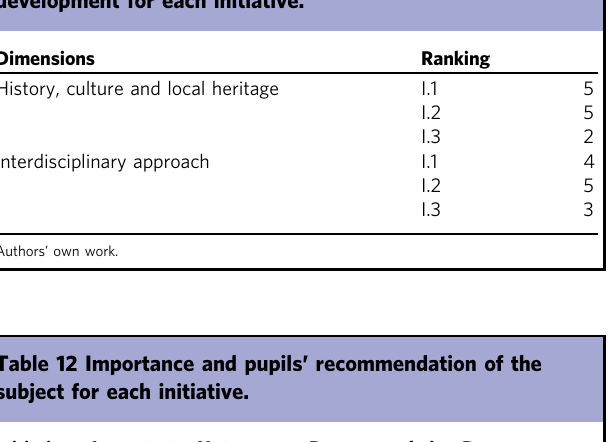
Table 13 Dimensions of the model (TB.4) and the level of development for each initiative.